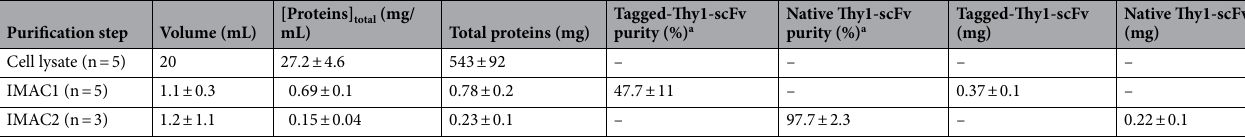
Table 1. Summary of Thy1-scFv purification from 1 L bacterial culture. a Value based on analysis of Thy1-scFv band intensity using BioRad Gel-Doc system.